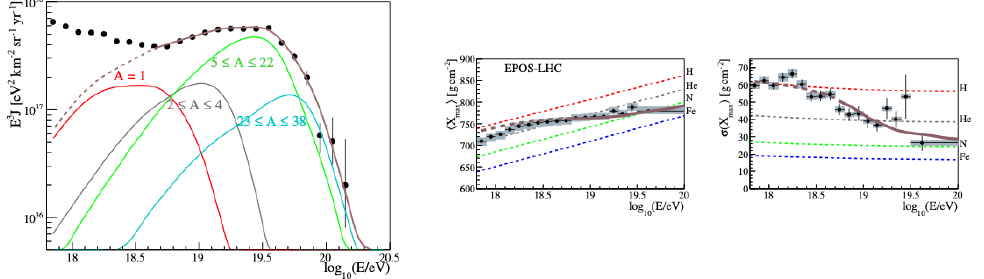
Figure 1. Left : Energy spectrum obtained with the best-fit parameters for [8]. Partial spectra are shown with di ff erent colors, total spectrum with brown. Full circles show the experimental spectrum. Right : average and standard deviation of the X max for data (full circles) and best-fit prediction (brown). Pure H (red), He (grey), N (green) and Fe (blue) are shown as dashed lines. Only the energy range where the brown lines are solid is included in the fit. From [8].